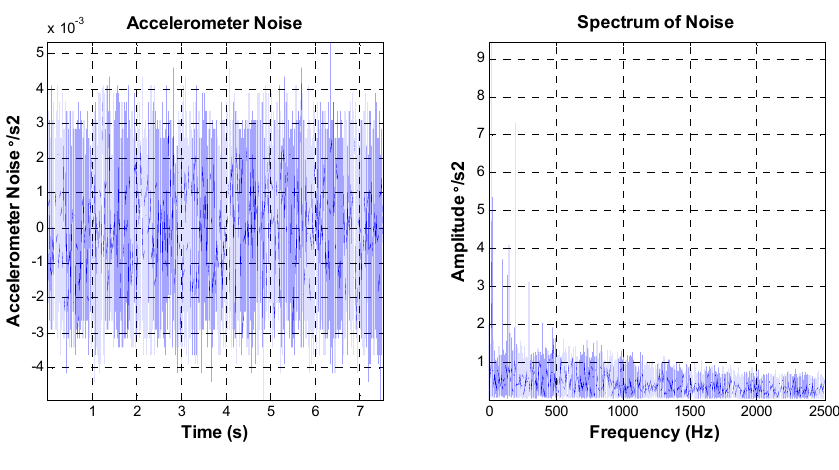
Figure 8. MEMS accelerometer noise characteristics.